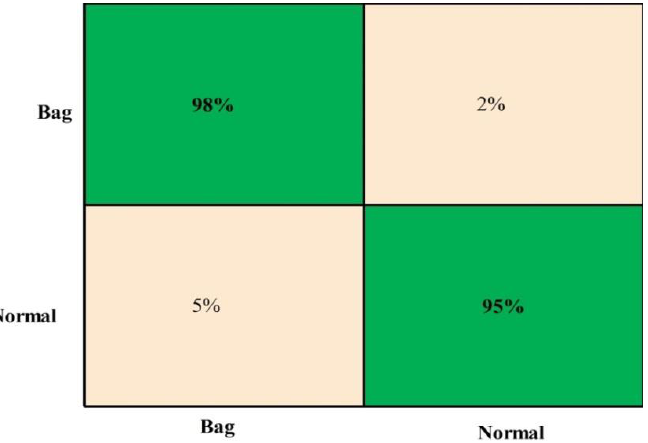
Figure 12. Confusion matrix of OaA-SVM for normal walking and walking while carrying a bag classification.